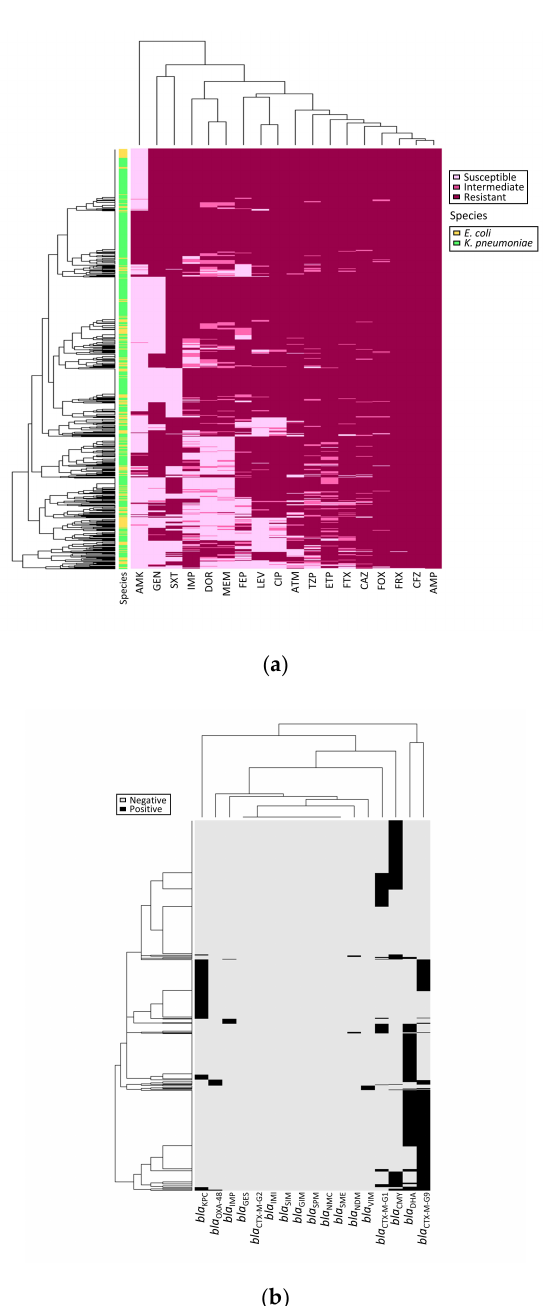
Figure 1. (a) Antimicrobial susceptibility profile and (b) gene detection heatmap for 660 carbapenem-nonsusceptible Enterobacteriaceae isolates. Abbreviations: AMK, amikacin; GEN, gentamicin; SXT, trimethoprim/sulfamethoxazole; IMP, imipenem; DOR, doripenem; MEM, meropenem; FEP, cefepime; LEV, levofloxacin; CIP, ciprofloxacin; ATM, aztreonam; TZP, piperacillin–tazobactam; ETP, ertapenem; FTX, cefotaxime; CAZ, ceftazidime; FOX, cefoxitin; FRX, ceftriaxone; CFZ, cefazolin; AMP, ampicillin. Indicated are negative and positive PCR detection results for each gene. Detection results for bla ESBL and bla AmpC indicate that 92 isolates carried bla CTX-M-G1 (92 / 660, 13.9%), 250 carried bla CTX-M-G9 (250 / 660, 37.9%), 165 bla CMY (165 / 660, 25.0%), and 222 bla DHA (222 /